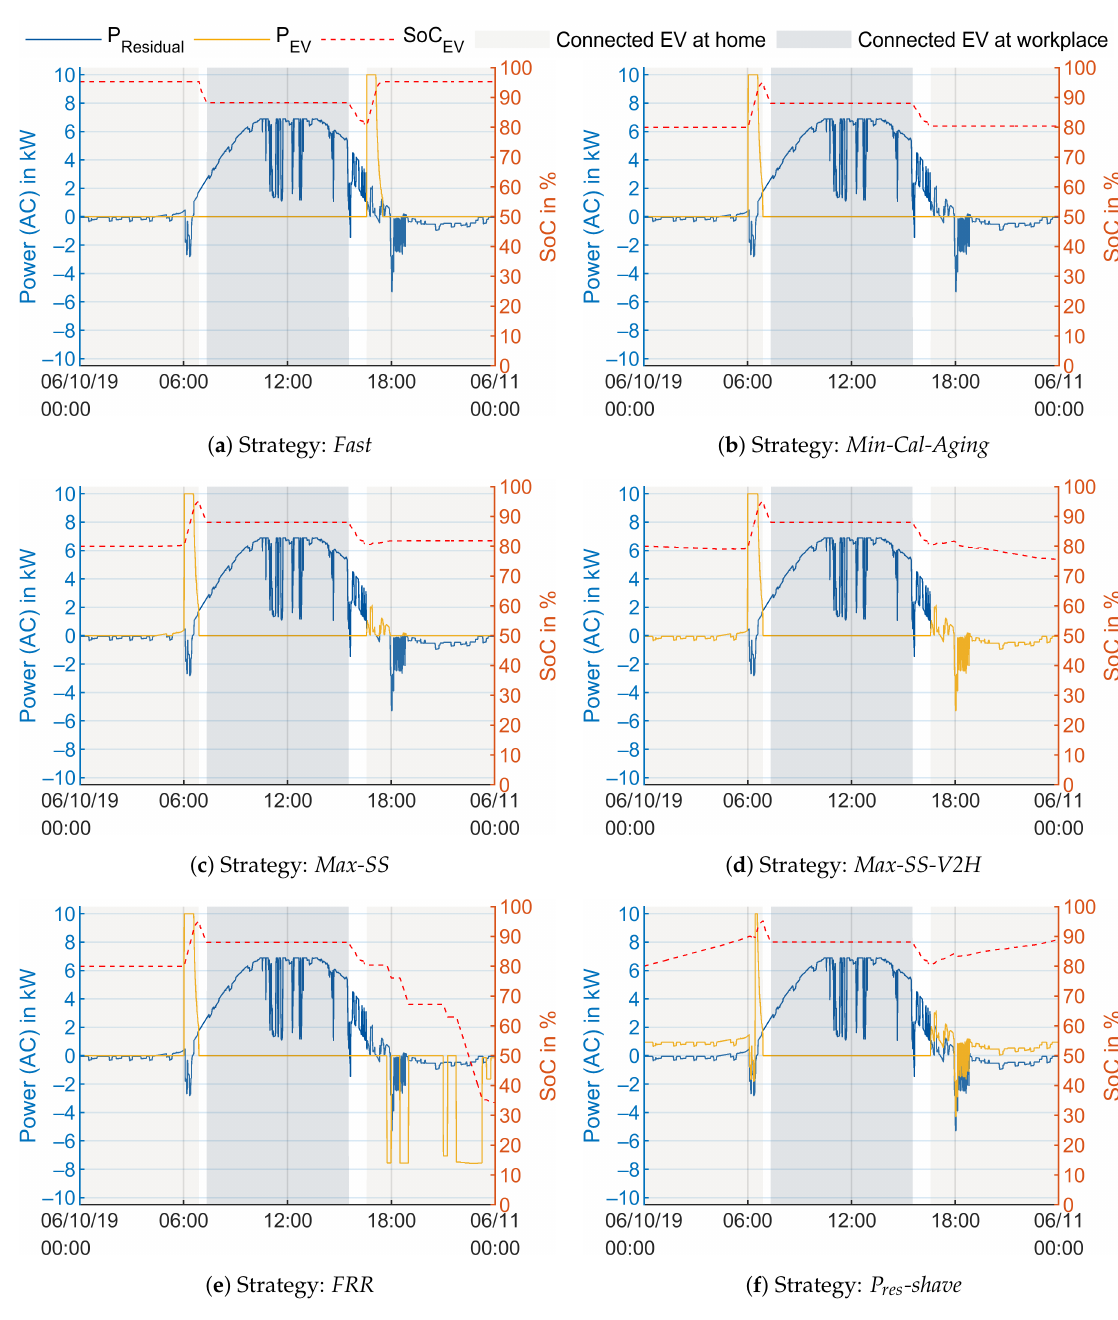
Figure 7. Power flows for the household on 10th of June 2019 for mobility profile Worker and charging only at home. P Residual = P PV − P inflexibleLoad . All power flows on AC